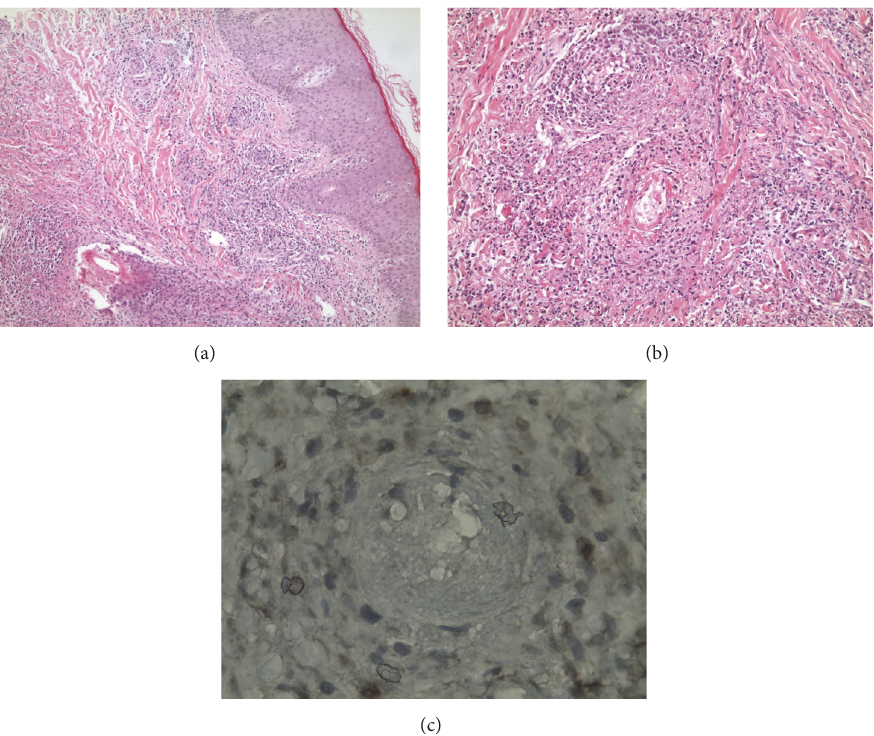
Figure 2: (a, b) Regular acanthotic epidermis, a dense dermal infiltrate of pleomorphic atypical lymphoid cells, and destruction of the blood vessels’ walls by abnormal lymphocytes. (c) The cells were strongly positive for